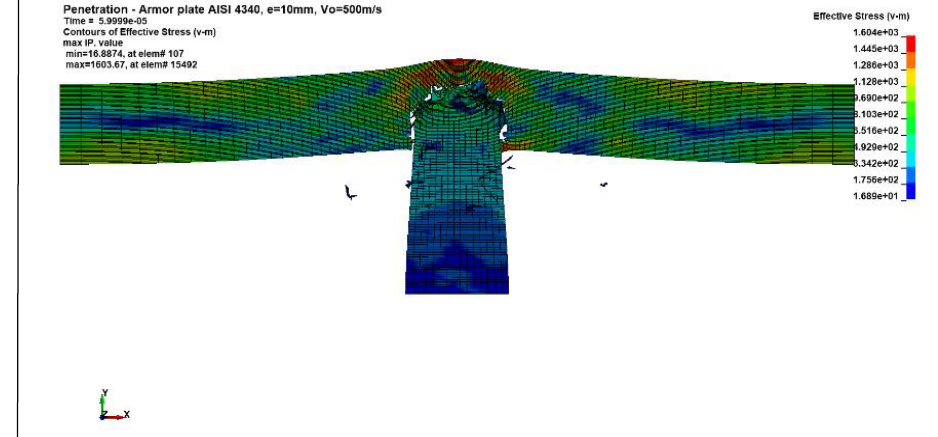
Figure 5 – Von Misses equivalent stress, time of analysis 0.05 ms – Model 1 Рис. 5 – Von Misses эквивалентное напряжение, время анализа 0.05 ms – Модель 1 Слика 5 –Von Misses-ов еквивалентни напон, време анализе 0,05 ms – модел 1